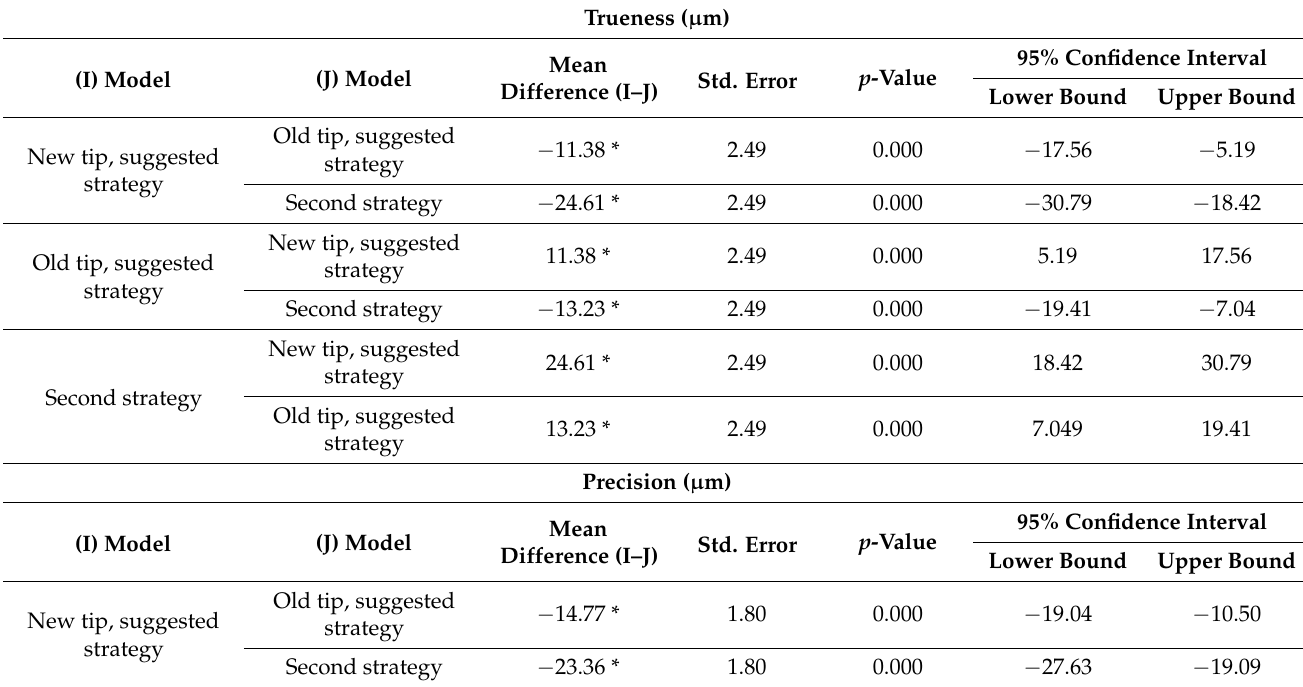
Figure 7. Box plots showing the median, quartile, and minimum and maximum values of the mean differences of trueness and precision between two different intraoral scanning procedures and two different tips used. Table 1. Mean difference in trueness and precision between two different strategies of intraoral digital impression and a new scanning